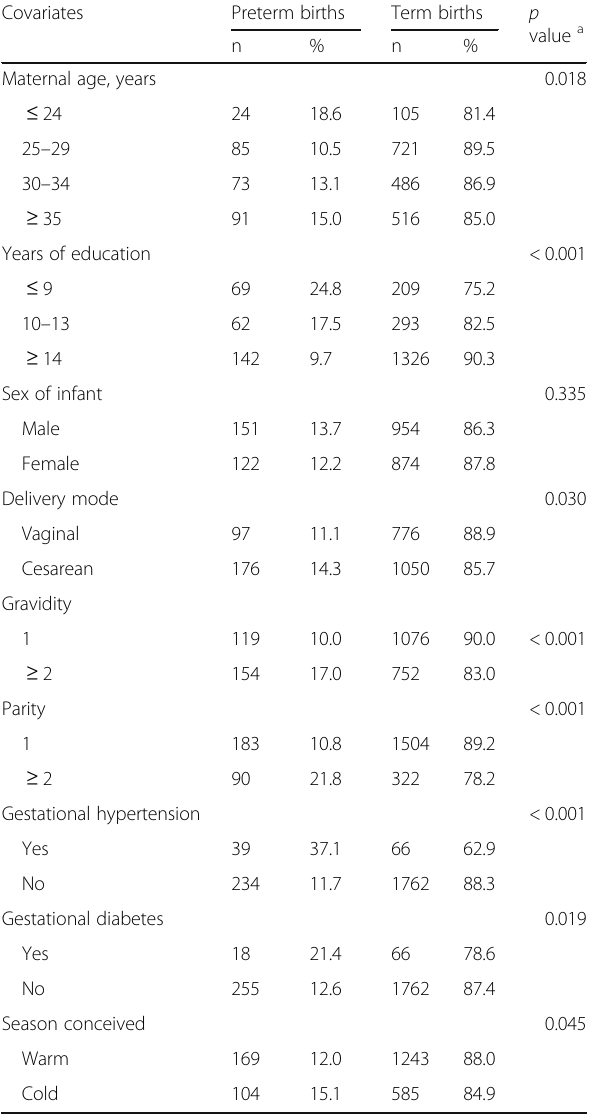
Table 1 Characteristics of the study population, by term and preterm births (Wuhan, China, November 1, 2013 to May